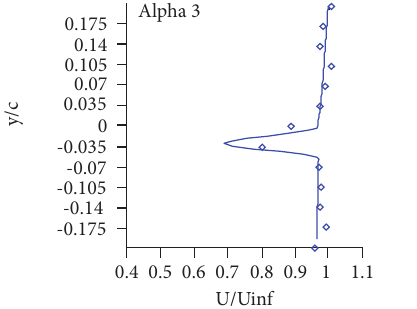
Figure 24. Streamwise velocity profile at x/c = 0.25, Mach =